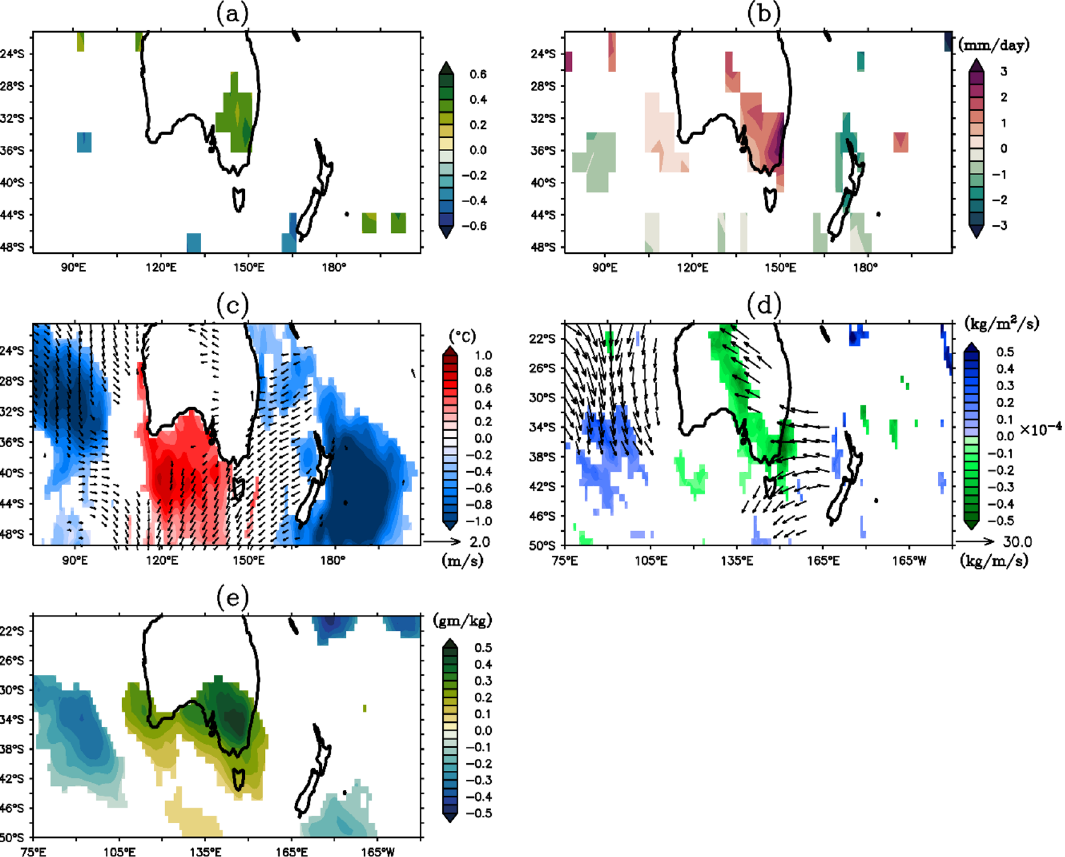
Figure 8. ( a ) Correlation field between IW4 and rainfall anomaly during austral summer. Composite of positive minus negative W4 extreme years in February ( b ) rainfall (in mm/day), ( c ) SST(shaded; in °C) and divergent wind at 850 hPa (vector; in m/s), ( d ) vertically integrated moisture divergence (shaded; in kg/ m 2 /s) and moisture transport (vector; in kg/m/s) for whole atmosphere (i.e. surface to 1 Pa), and ( e ) vertically integrated specific humidity (in gm/kg) for whole atmosphere (i.e. surface to 1 Pa). Values less than 95% significance level are